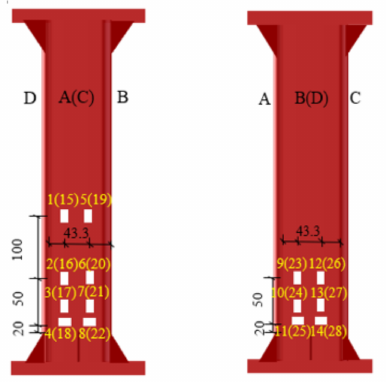
Figure 3. Layout of strain gauges.